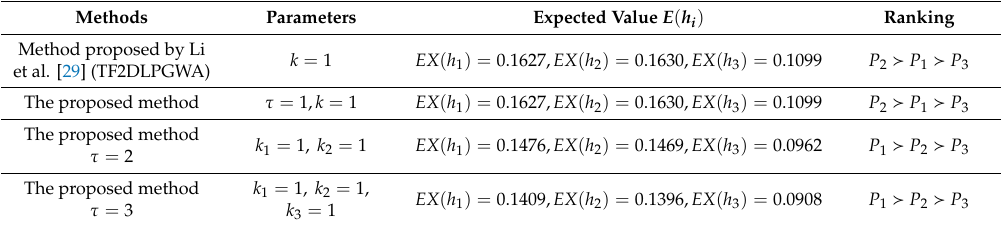
Table 8. Results obtained by di ff erent MADM